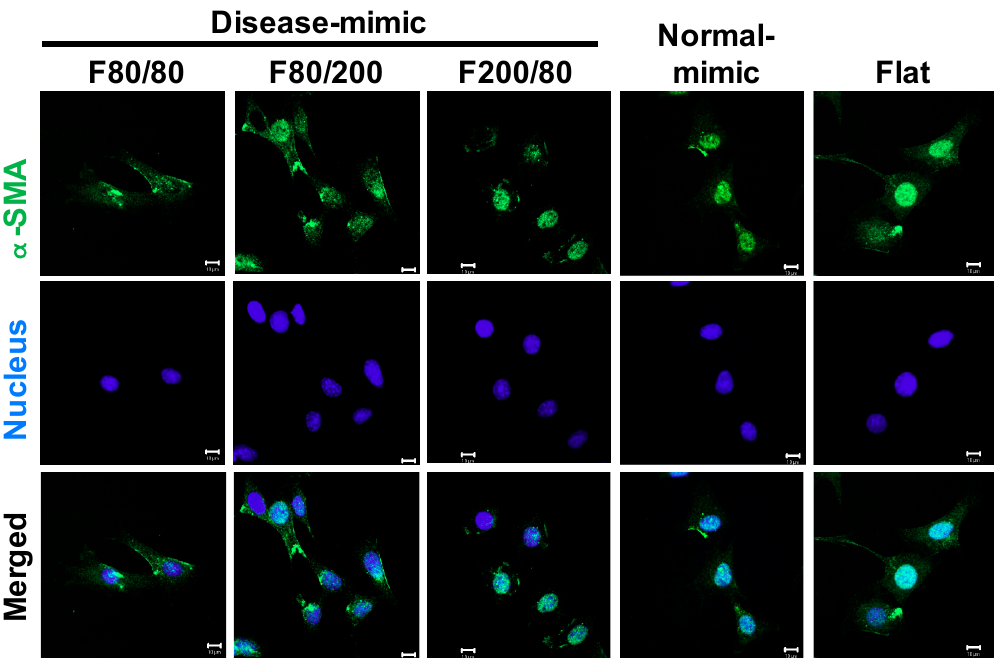
Figure 5. Alpha-smooth muscle actin ( α -SMA) expression in MES13 cells influenced by disease- and normal-mimic nanopatterns. Confocal microscopy images show α -SMA (green) and nuclei (blue) in cells after culturing on TiO 2 nanopatterns for 24 h. Scale bar = 10 µ m.